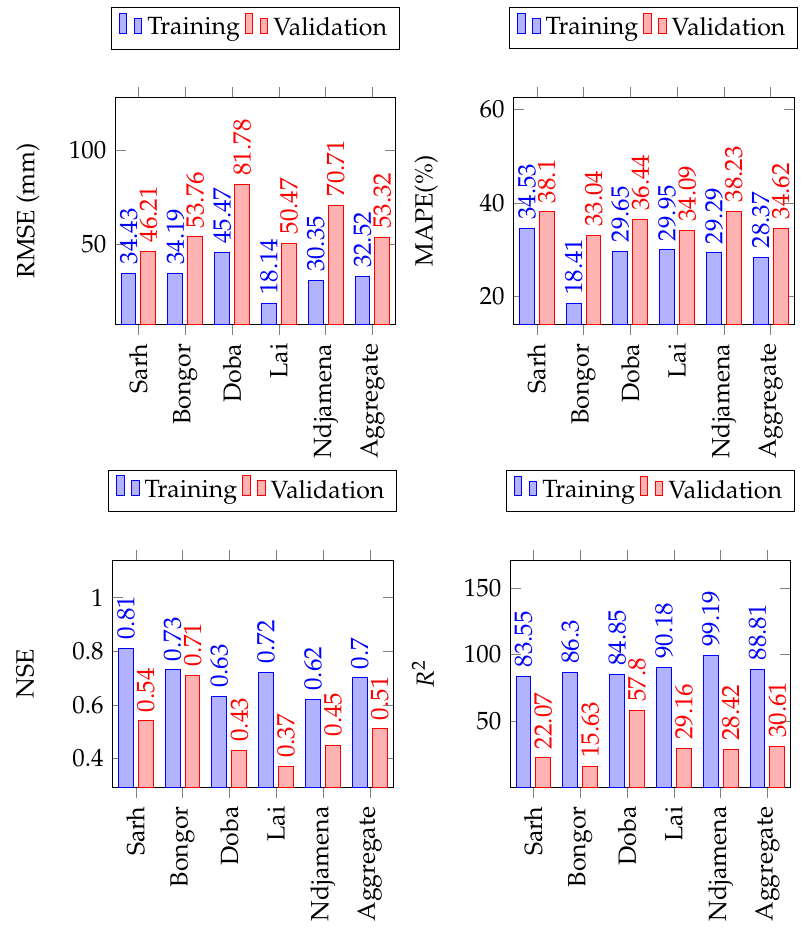
Figure 5. Comparison of SDSM performance on the training and validation sets for monthly precipi- tations forecast in the Lake Chad